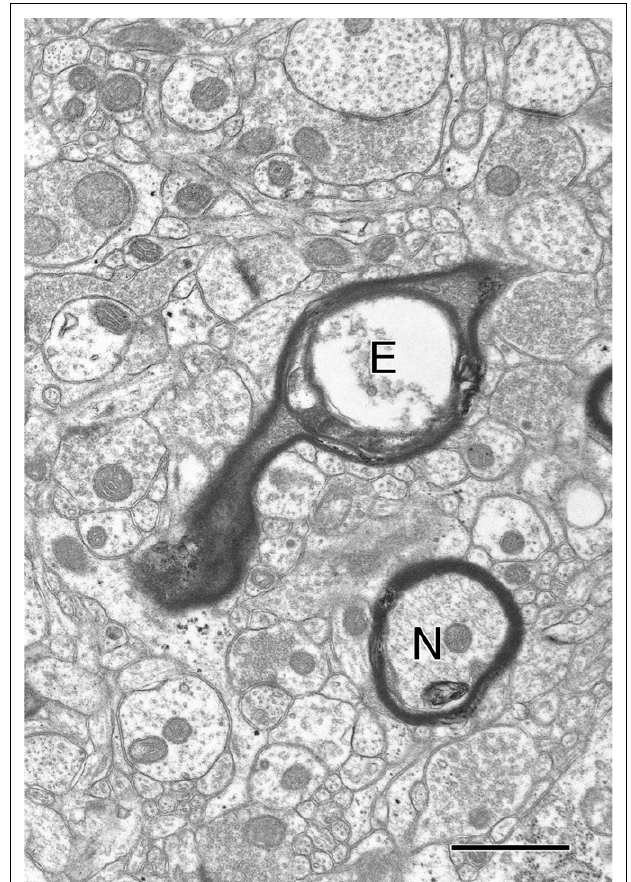
FIGURE 2 | In the fi eld is a normal nerve fi ber (N) and another nerve fi ber (E) in which the axon has degenerated, leaving an empty sheath. Layer 4 from area 46 of a 27-year-old rhesus monkey. Scale bar = 1